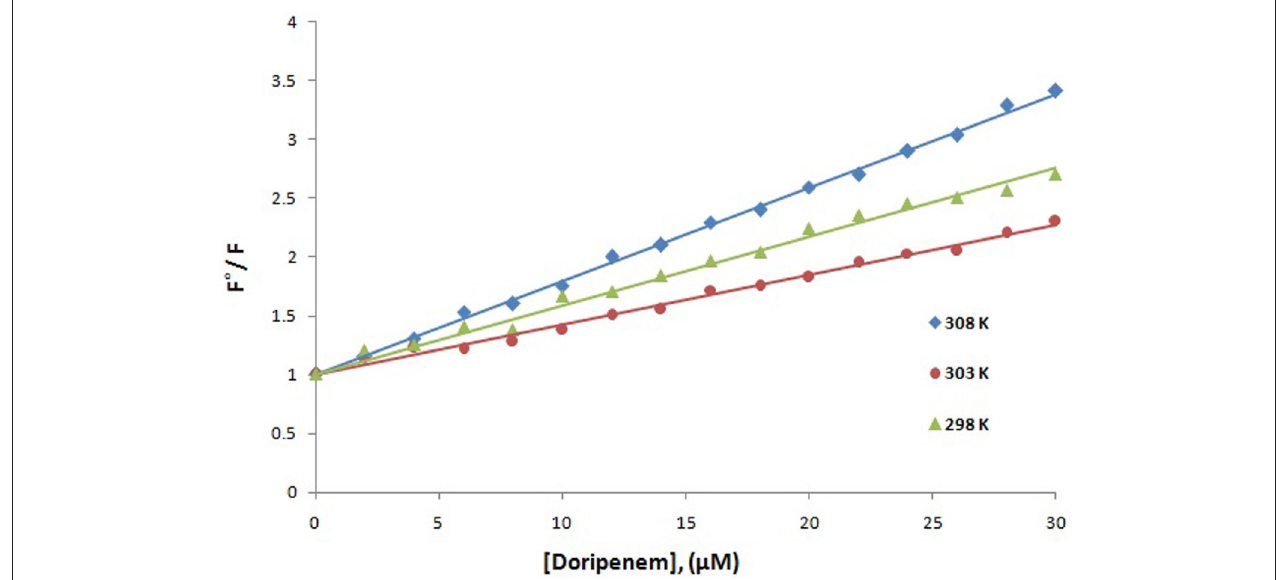
FIGURE 3 | Stern-Volmer plot for quenching of CTX-M-15 (2 µ M) in presence of doripenem (from 0 to 30 µ M) in 50 mM sodium phosphate buffer at pH 7.4 is shown.